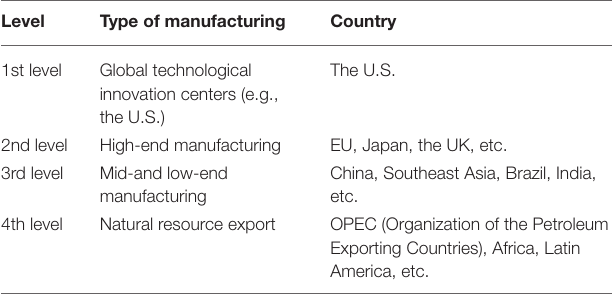
TABLE 1 | The four levels of global manufacturing.